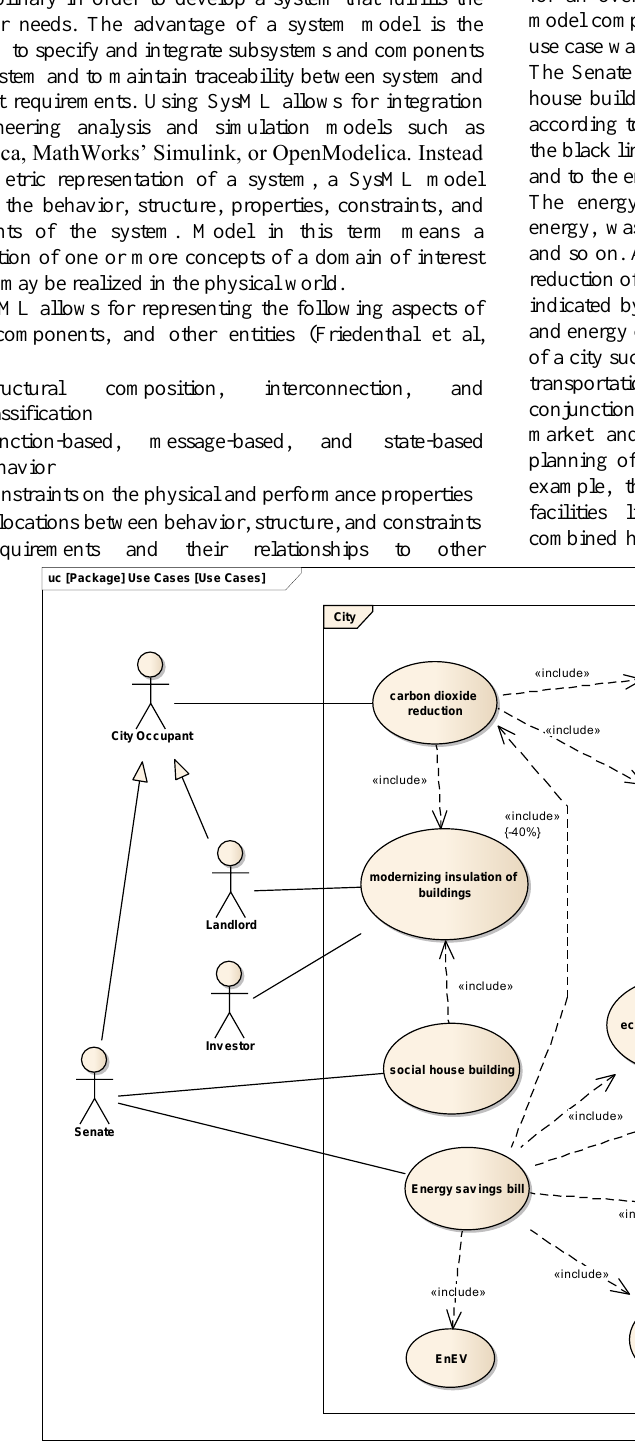
Figure 5. specific use case for using a city system